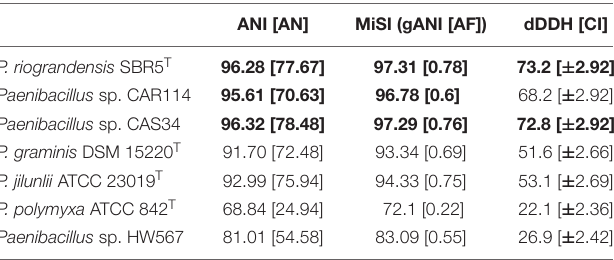
TABLE 2 | Comparison of P. sonchi X19-5 T with Paenibacillus strains through different whole-genome based